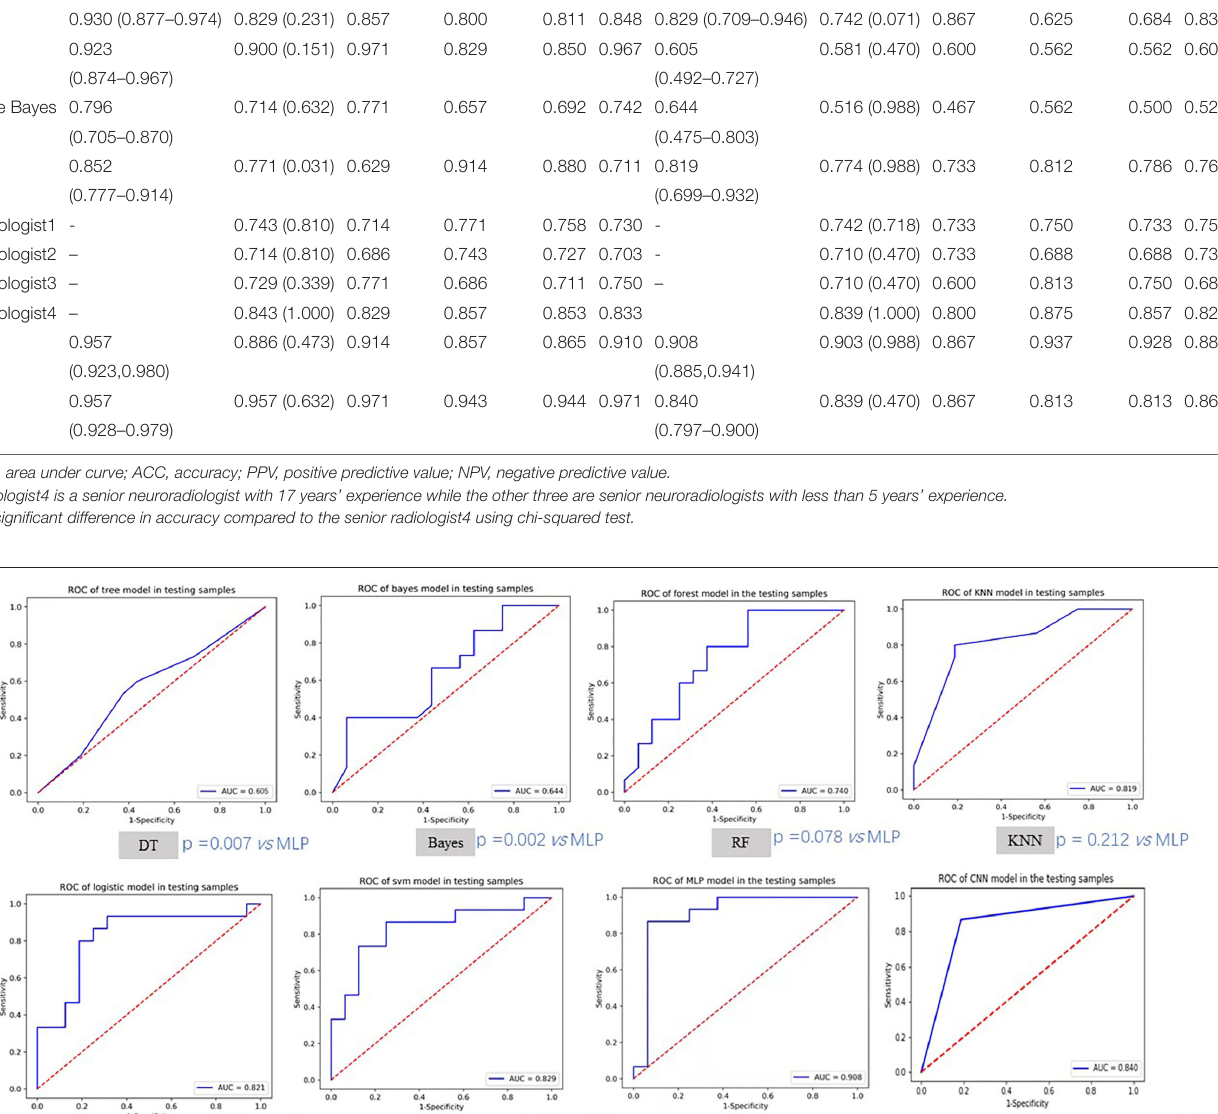
(26, 27). Radiomics enabled the conversion of original images into high-dimensional feature spaces that allowed an improved performance in PCNSL and glioma. Radiomic ML